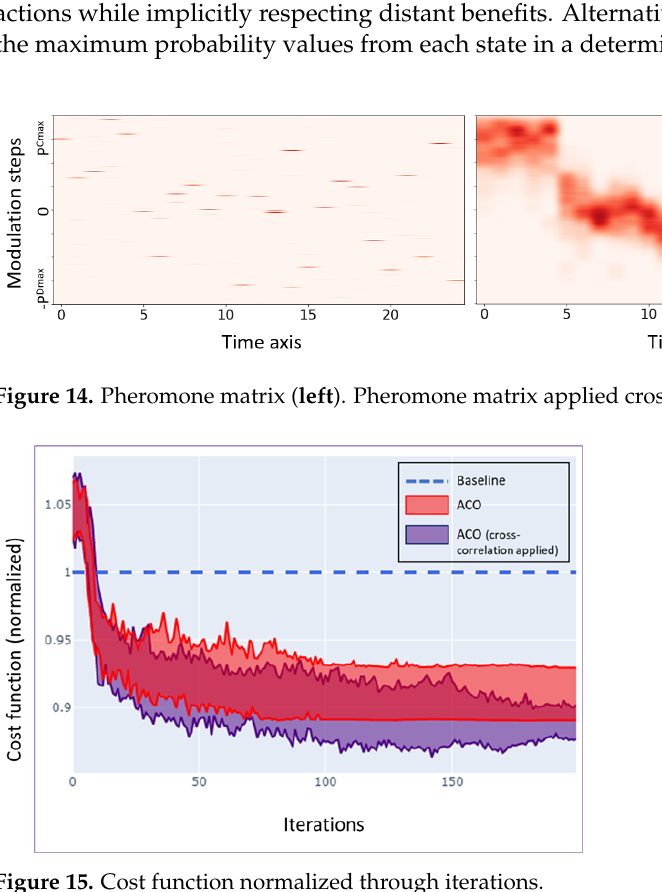
Figure 15. Cost function normalized through